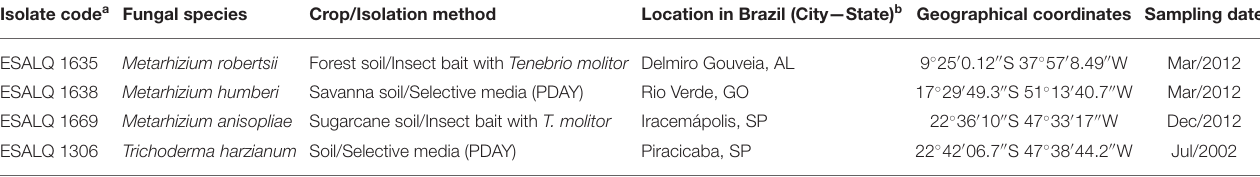
TABLE 1 | Description of fungal isolates used in the